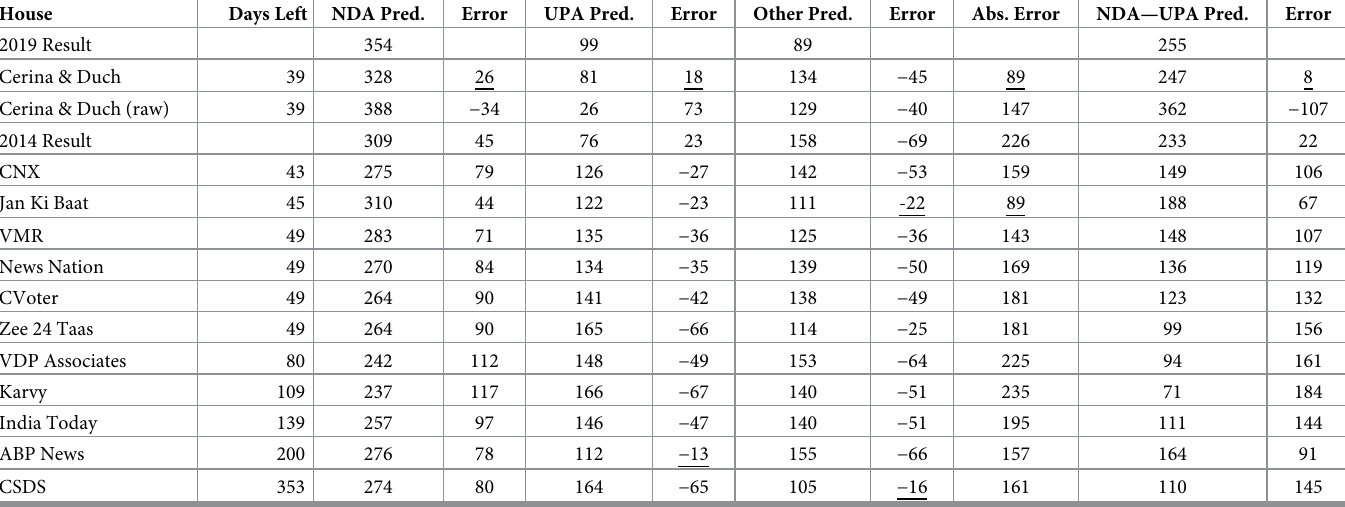
Table 3. Seat projections and errors across pollsters. Performance of two baseline predictions (the past-election results and the uniform-swing projection from the raw, non-modeled online data). Underlined are the best performing pollsters for each column. In some case we present two bold quantities per column because the best per- forming was so outdated—we highlight a second-best performing poll that was more recent and comparable. House Days Left NDA